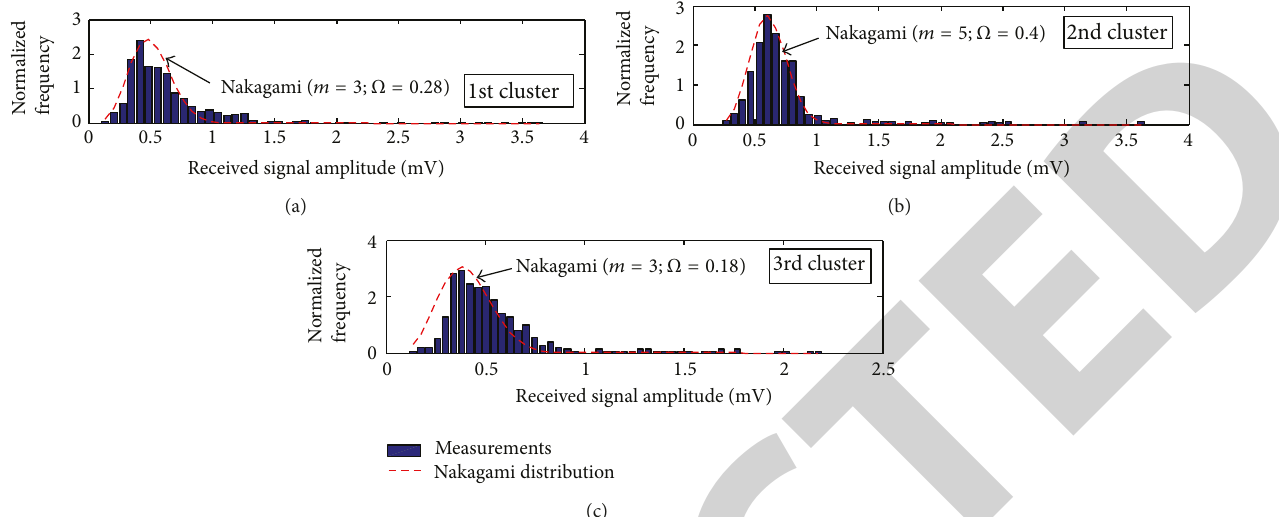
Figure 4: Histogram of measurement data for the dominant paths within the three clusters that are best fit to Nakagami distributions.